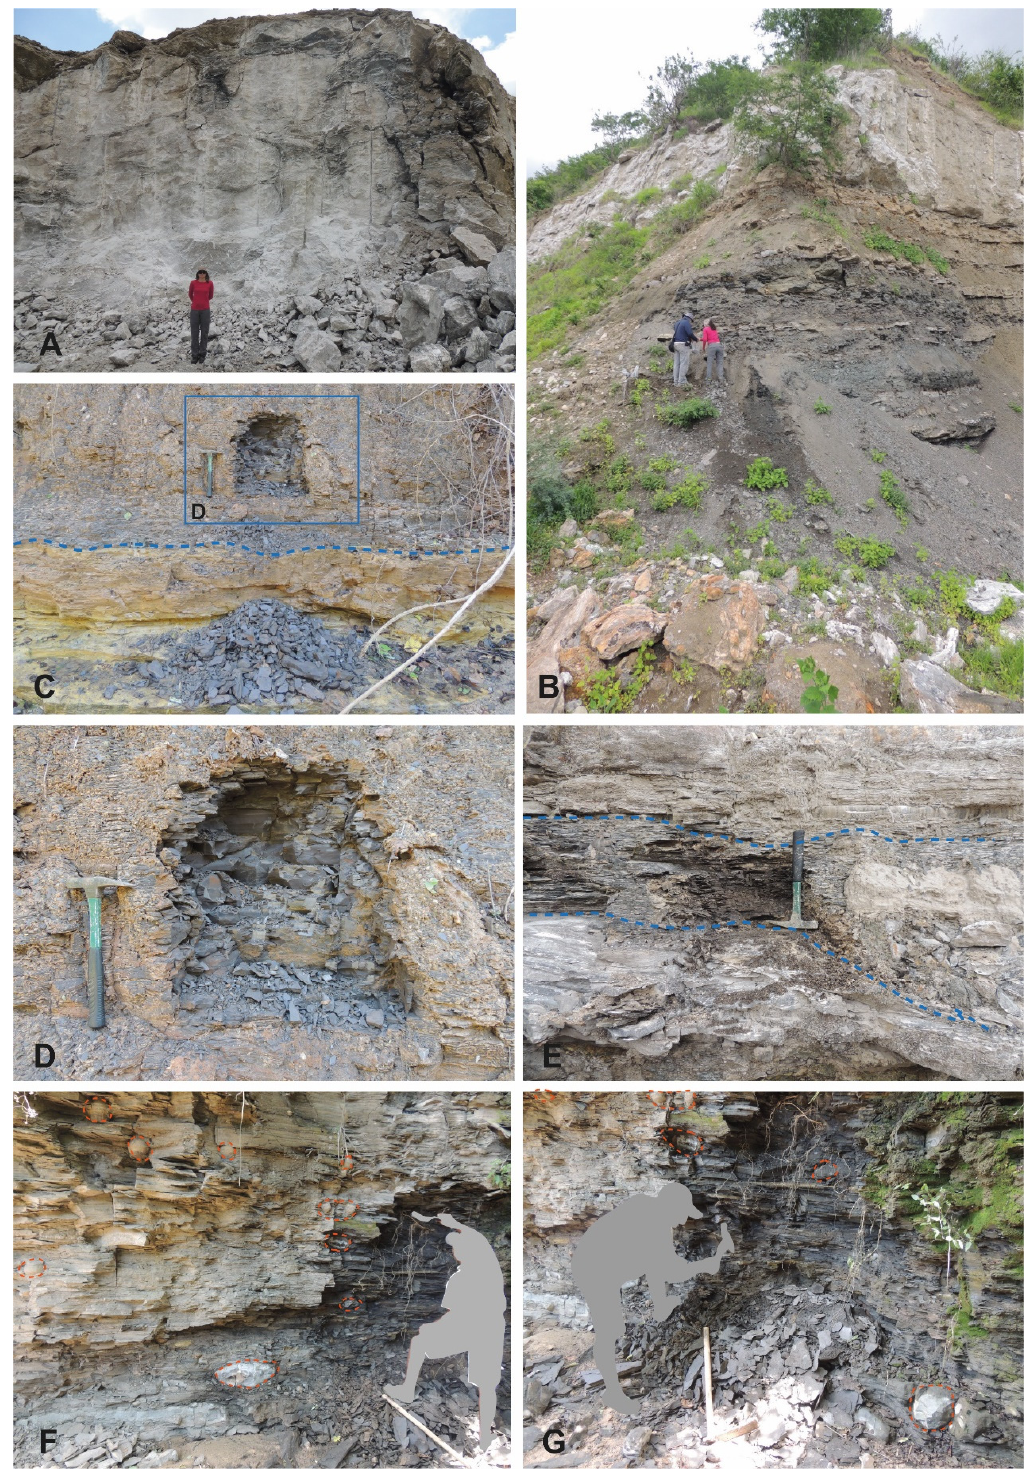
Figure 3. Outcrops of the evaporites and shales collected in the study sections and main features of the lithofacies. ( A ) Evaporite from the S ã o Jorge Mine (SJMS). ( B ) Black shales from the Conceiç ã o Preta Mine section (CPMS). ( C ) A transition between limestone and a sampled shale. ( D ) Detail on where the sample DR-BA-10 (CPMS) was collected. ( E ) Crato Formation shale sample (DR-BA-22) located between carbonate beds from the Sobradinho River section (SBRS). ( F ) Detail on nodular carbonate concretions from the Sobradinho River’s shale (Romualdo Formation). ( G ) Detail on where the sample DR-BA-19 was collected in the Sobradinho River section